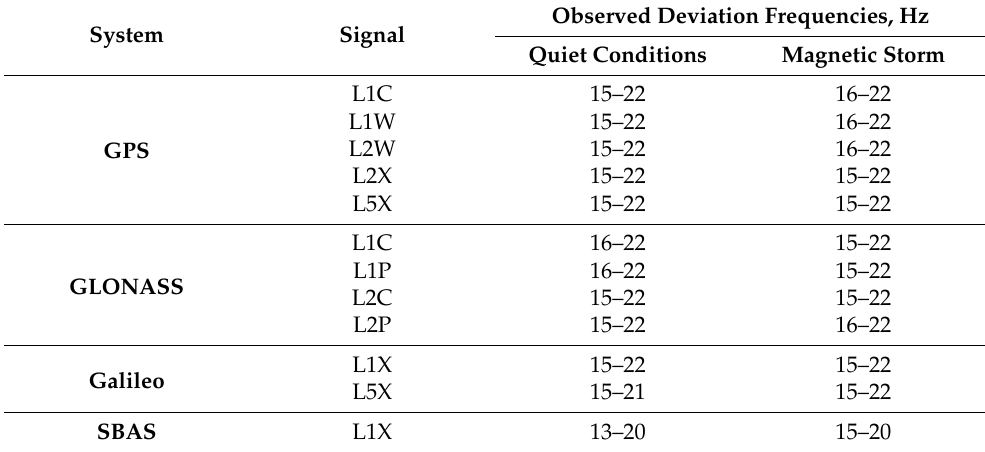
Table 3. The deviation frequencies obtained from Javad receiver at 50 Hz sampling